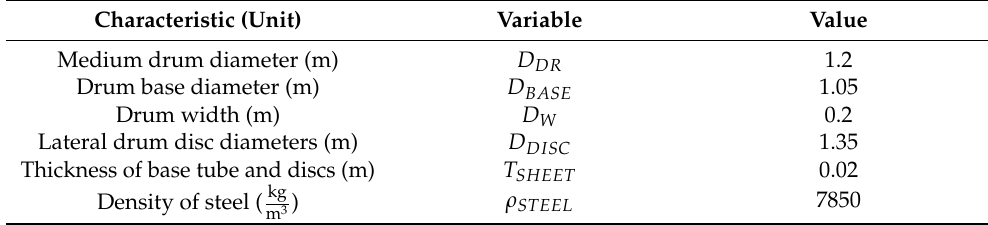
Table 9. Key parameters for gearbox design and drive control, in addition to design specifications provided in Table 6. Values are chosen based on experience and are believed to be representative for solutions on today’s